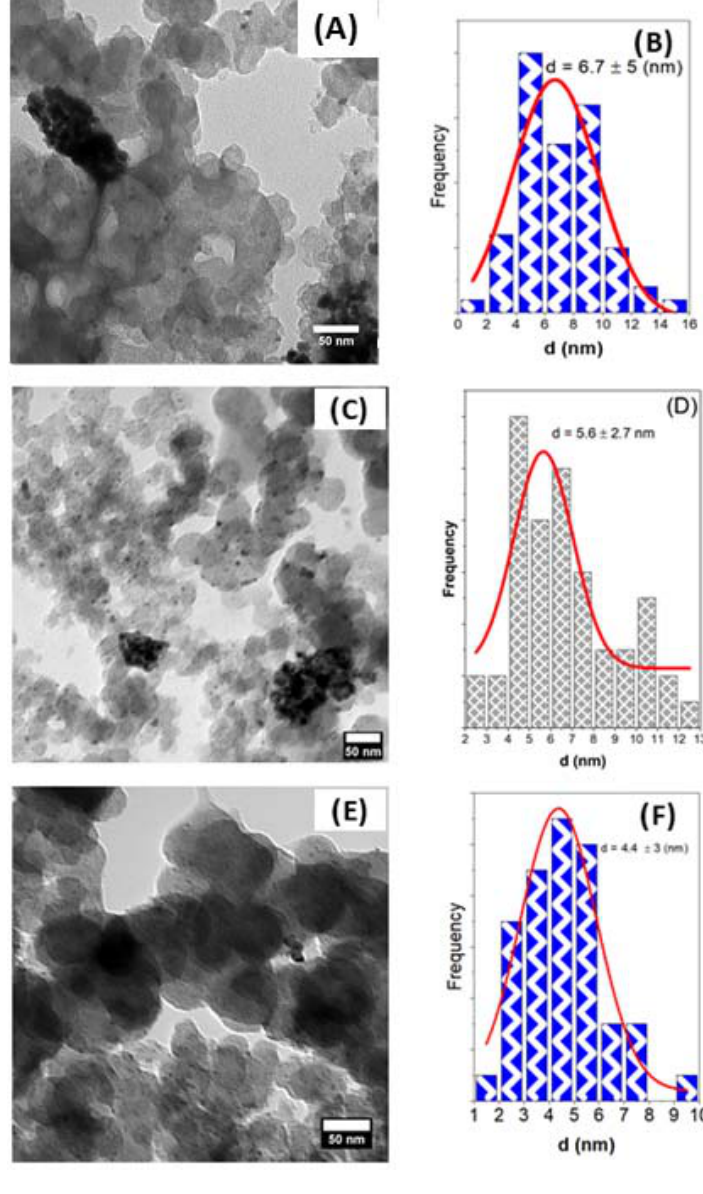
Figure 3. TEM Micrographs and the respective particle size distribution of Pd/C ( A , B ), Pd 4 Ag 2 Ni 1 /C ( C , D ), and PdAgNi/C ( E , F ).